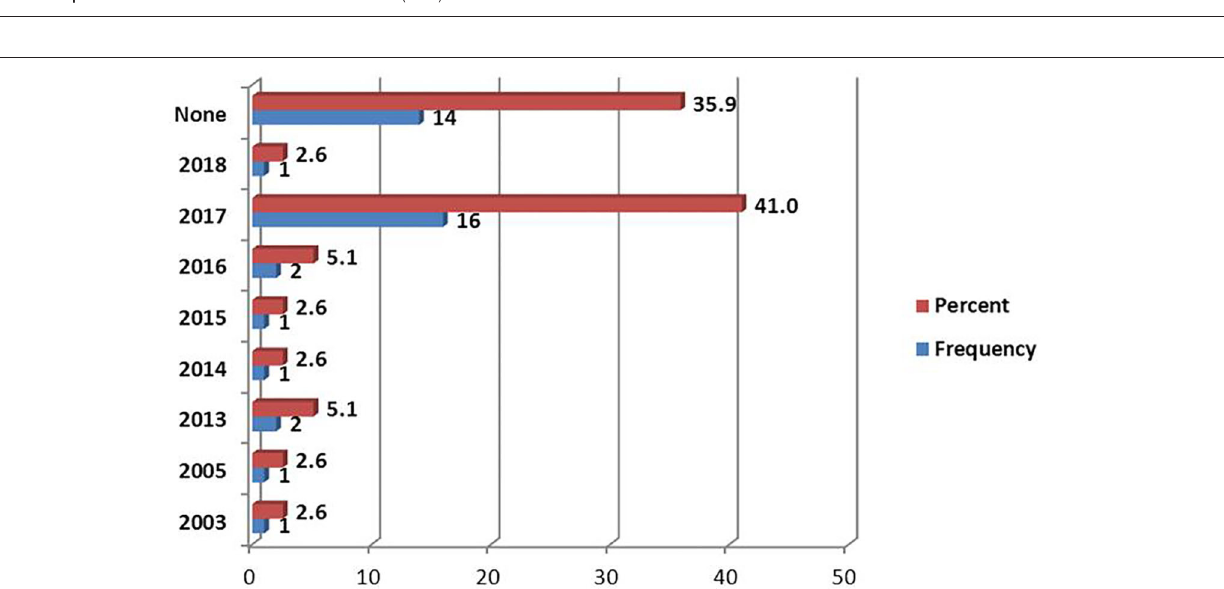
FIGURE 4 | Versions of Standard treatment Guidelines (STG) used at the health facilities.